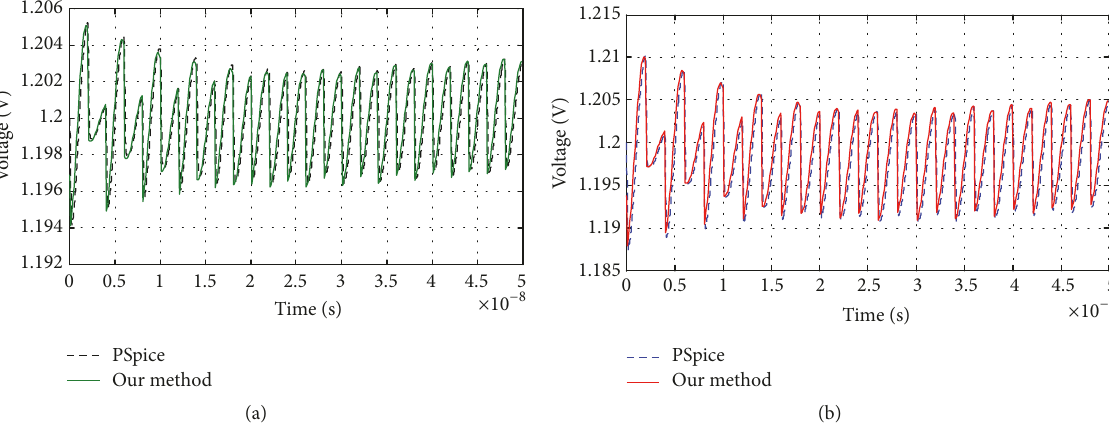
Figure 8: SSN waveform of the PDN near the second core; 𝐶